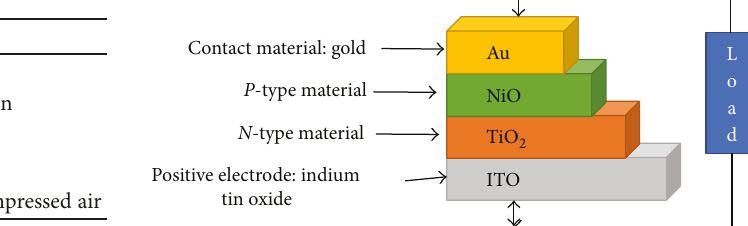
Figure 3: Experimental set-up of spray pyrolysis technique. Table 1: Optimum deposition parameters of SPT NiO fi lm.